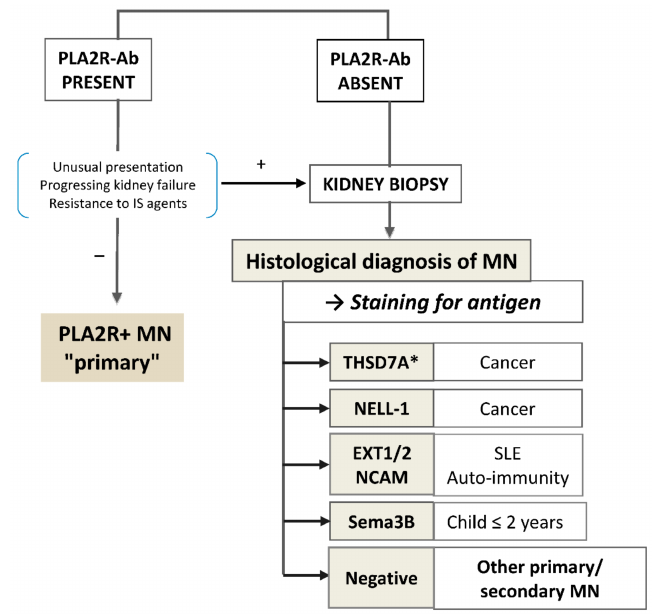
Figure 4. Simplified diagnostic algorithm. In patients with PLA2R-Ab but with unusual presentation or deteriorating renal function or resistant to IS agents, a kidney biopsy is indicated (+); it is not mandatory in the other cases ( − ). *An immunofluorescence test for the detection of circulating anti-THSD7A antibodies is available but as yet there is no consensus on whether a kidney biopsy should be performed or not in case of positive serology.